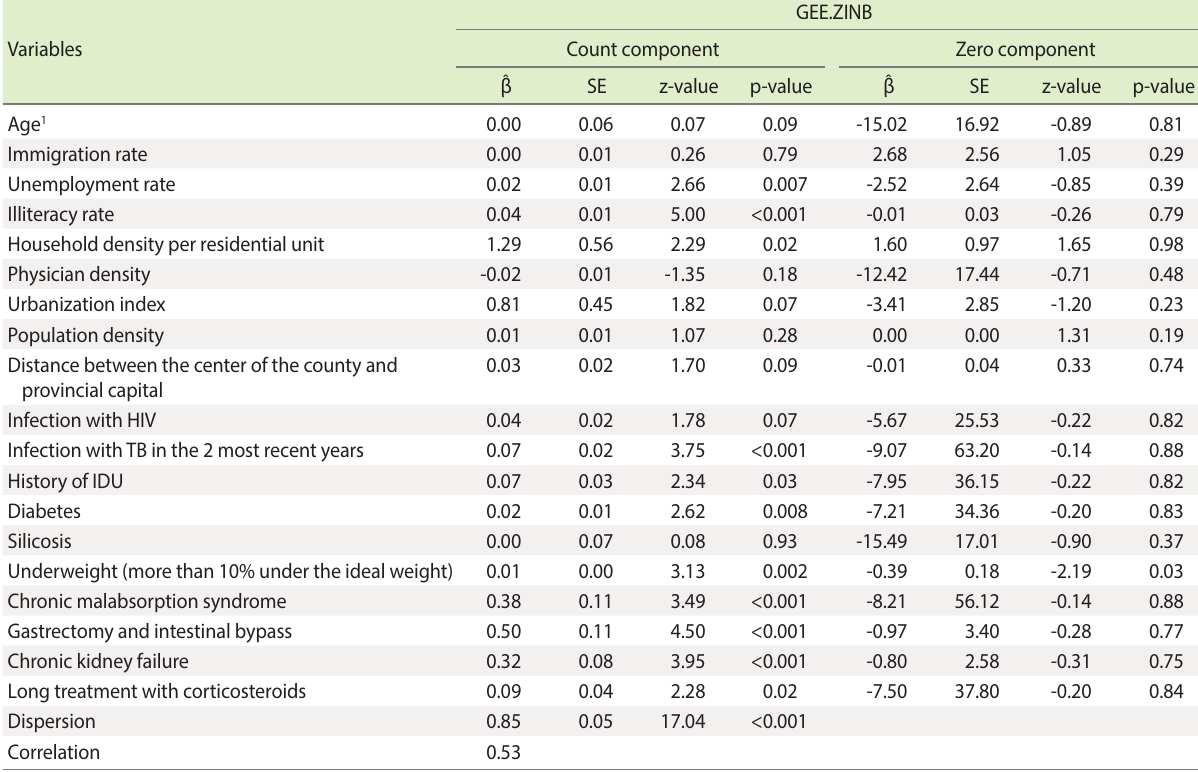
Table 4. Results of fitting the GEE-based ZINB model of the factors related to TB mortality in Iran